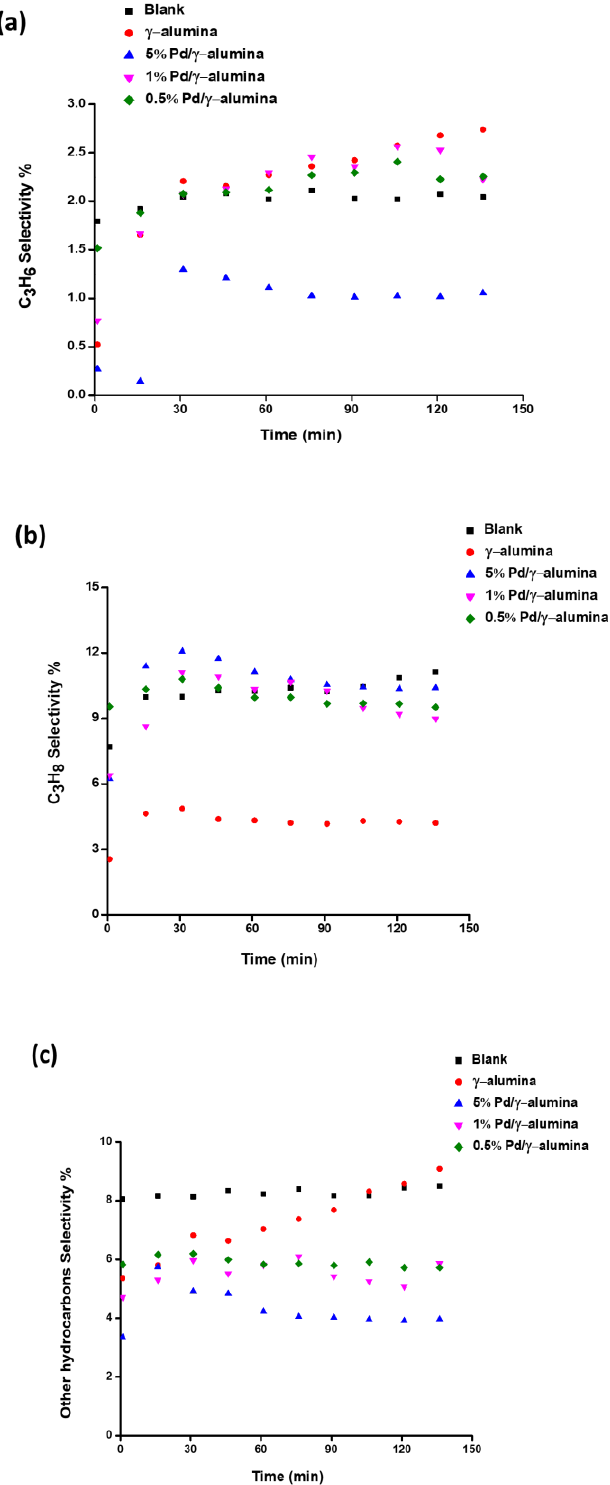
Figure 3. The e ff ect of packing the DBD plasma reactor with γ -alumina and Pd / γ -alumina with di ff erent loadings of Pd (0.5, 1, 5 wt%): ( a ) propylene selectivity, ( b ) propane selectivity, ( c ) other hydrocarbons’ selectivity.